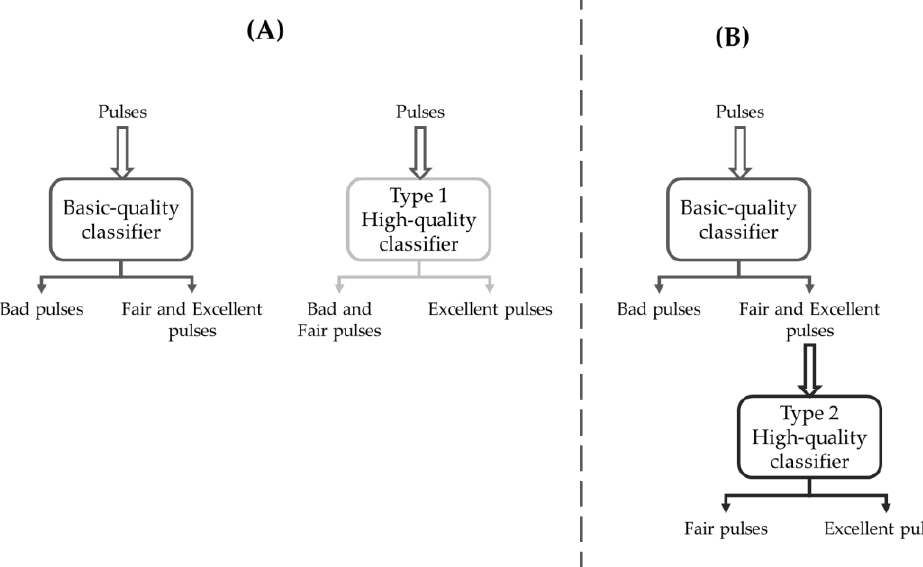
Figure 4. Schematic representation of the classification strategies. ( A ) Two independent classifiers: